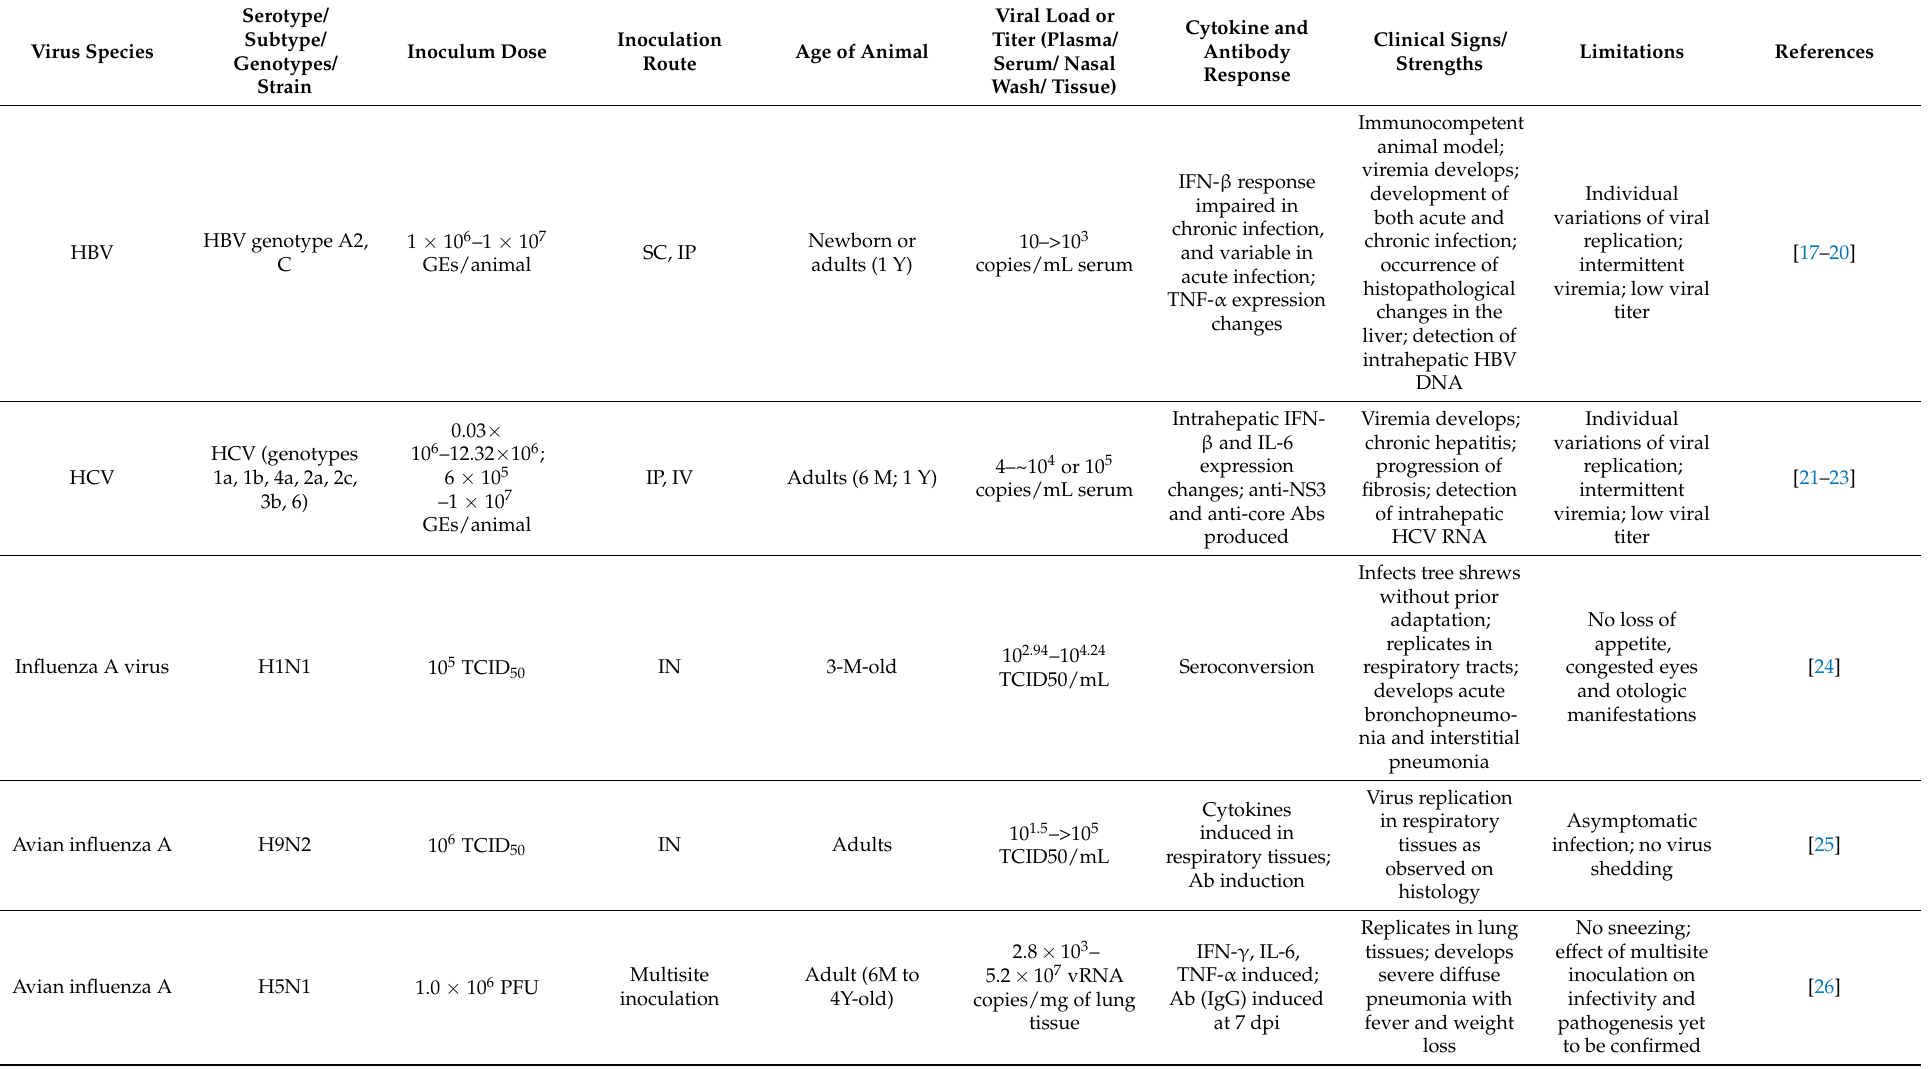
Table 1. Human viral infections in the tree shrew